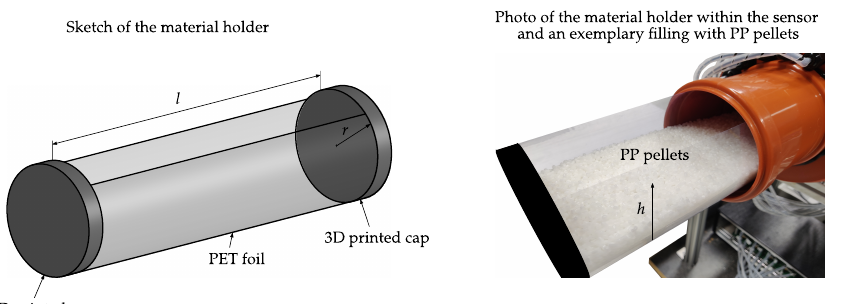
Figure 9. Sketch and a photo of the material holder, which is used to carry out measurement experiments with stationary material distributions [28].